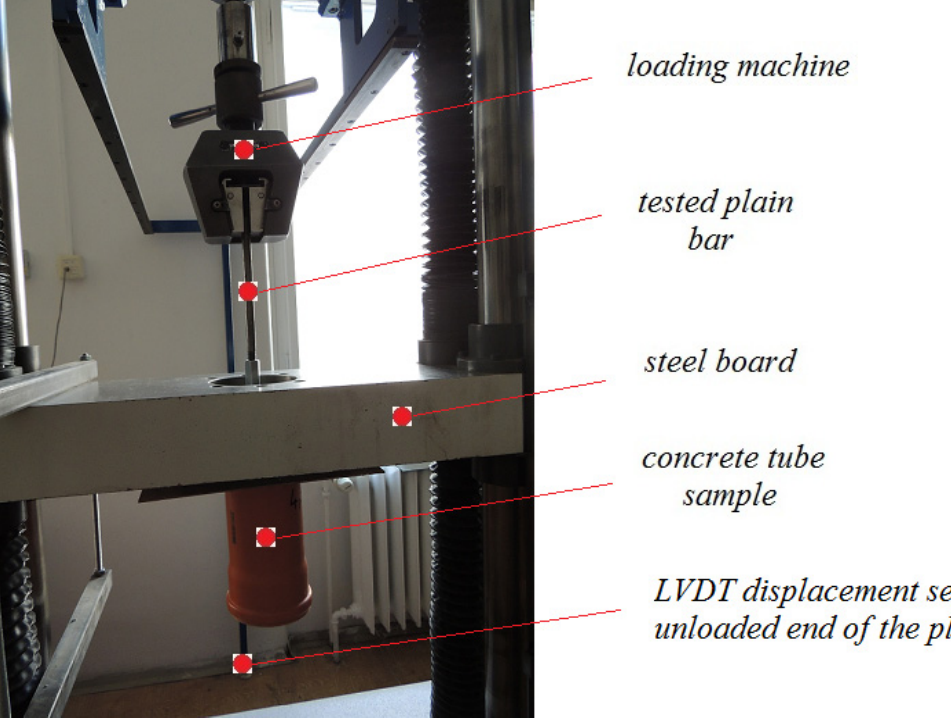
Figure 3. Experimental setup of pull-out test of bond strength between plain bar and cement paste.